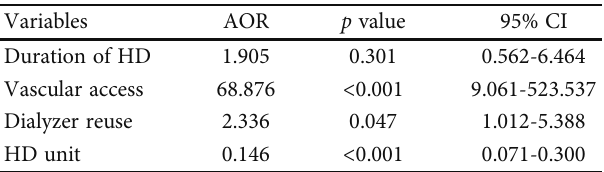
Table 5: Risk factors for seroconversion — multivariate analysis using logistic regression